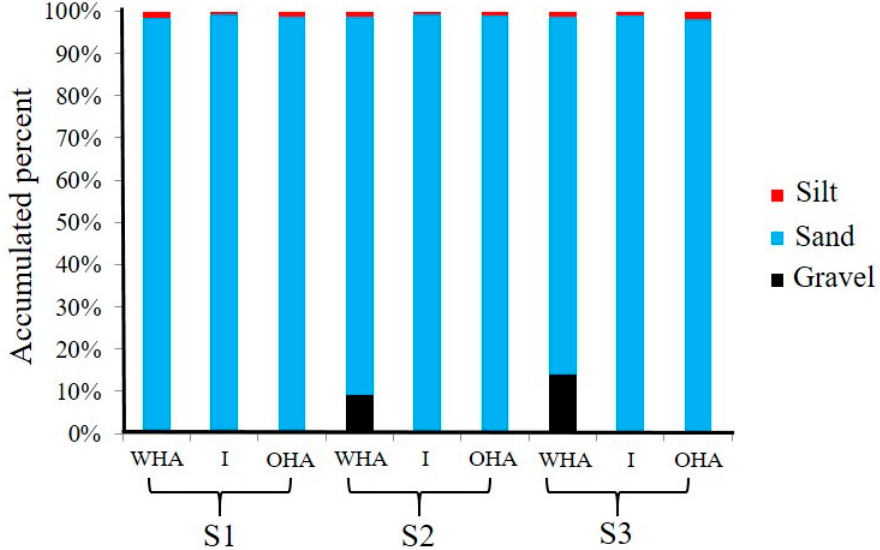
Figure 3. Textural composition of the sediments in the Shallow Submarine Hydrothermal System at Punta Mita. The x-axis indicates the area of each study site, and the y-axis indicates the cumulative percent of each grain size. S1, Site 1; S2, Site 2; S3, Site 3; WHA, area with hydrothermal activity; I, intermediate area; OHA, out of hydrothermal activity area.